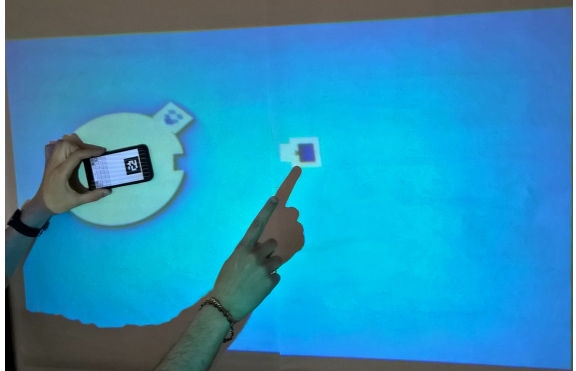
Figure 1. An example of a workflow assembled using